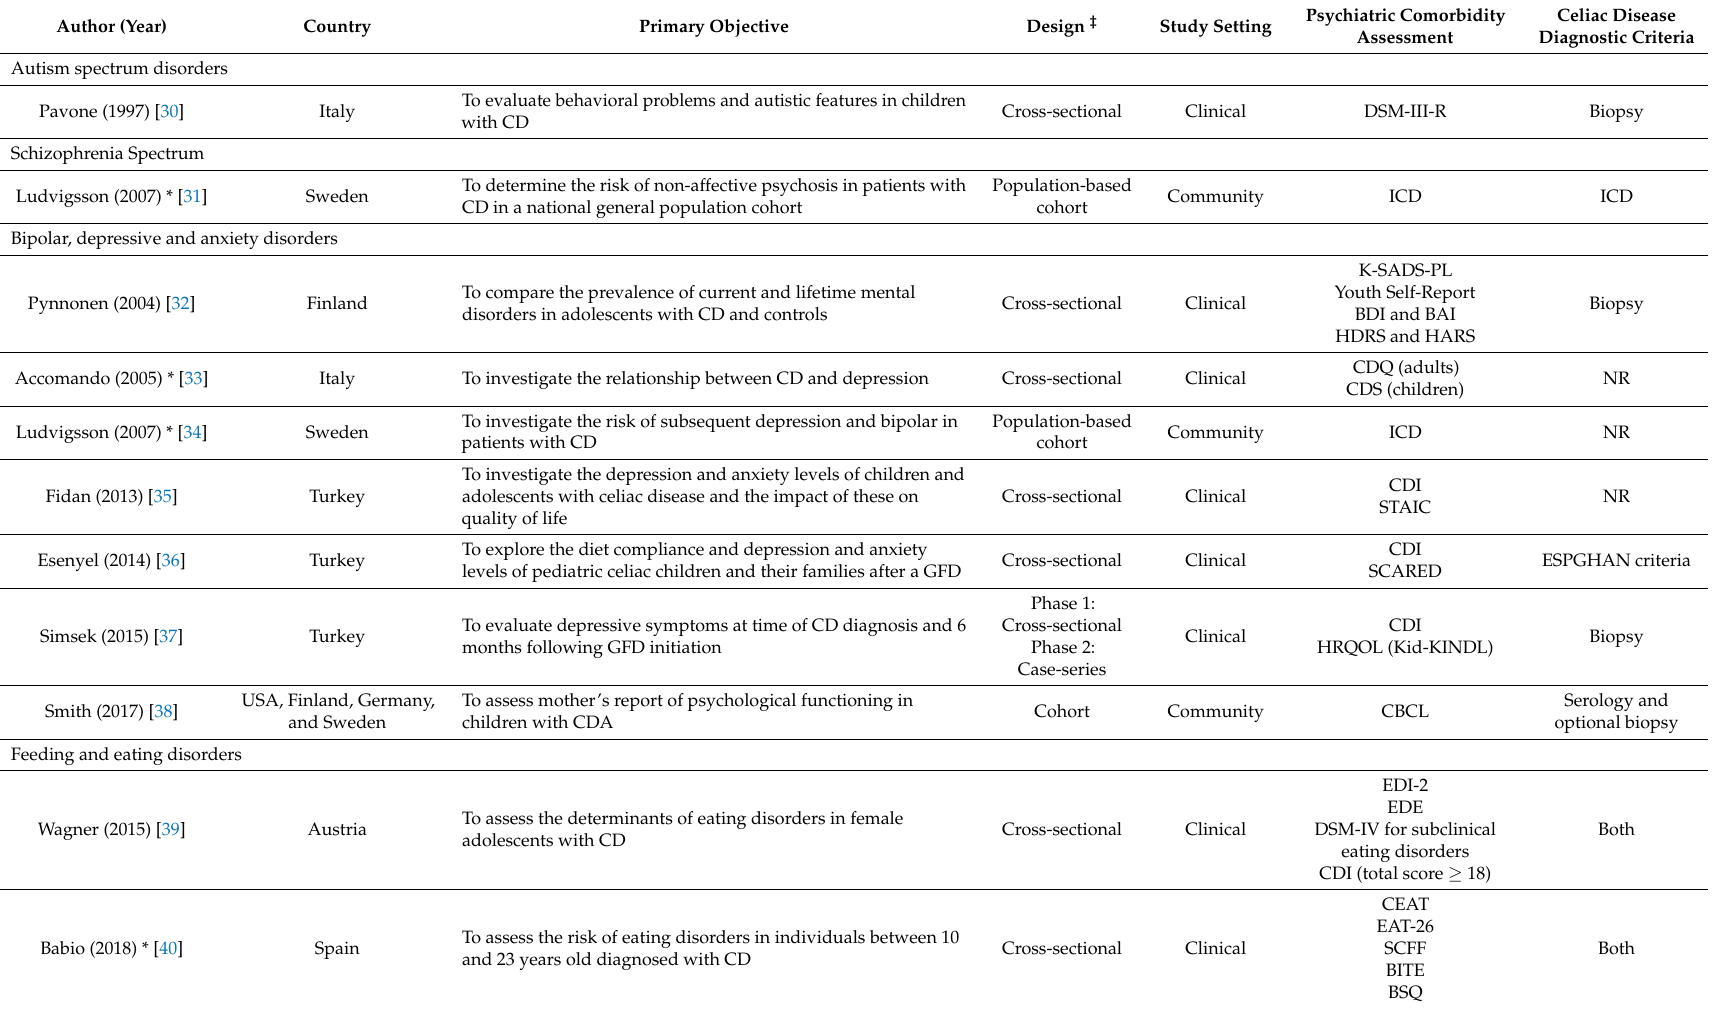
Table 1. Objectives and design of studies evaluating the association between gluten-related disorders and psychiatric disorders in children and young